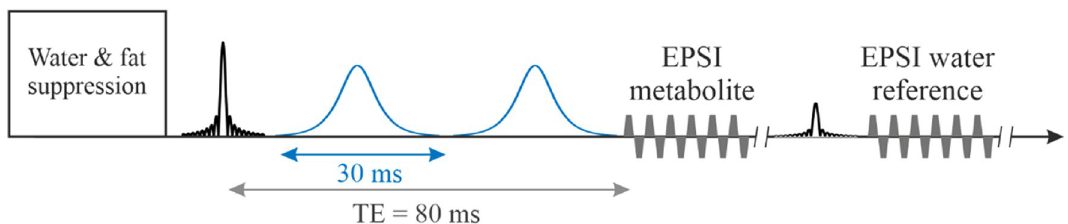
Scheme 1. Single-shot SLOW-EPSI sequences which makes use of phase compensated adiabatic 2π-pulses with complex secant hyperbolic modulation type (so called 2π-CSAP). The pulse durations of the 2π-CSAP pulses is 30 ms for scheme